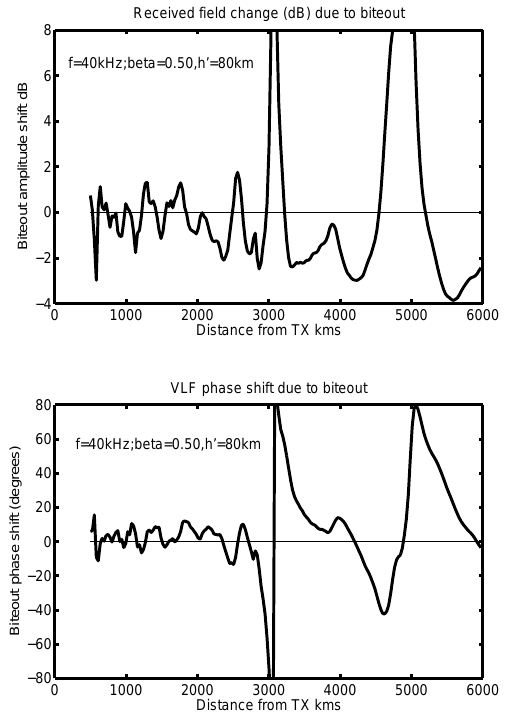
Fig. 6. Change in subionospheric received VLF amplitude and phase due to biteout, at f =40kHz. Amplitude shifts are not in- considerable at about − 2dB, with positive spikes at modal minima. Phase shifts are variable and up to 10 ◦ inside the first modal mini- mum at 3000km. At long range large shifts up to 80 ◦ are indicated with a preference for positive